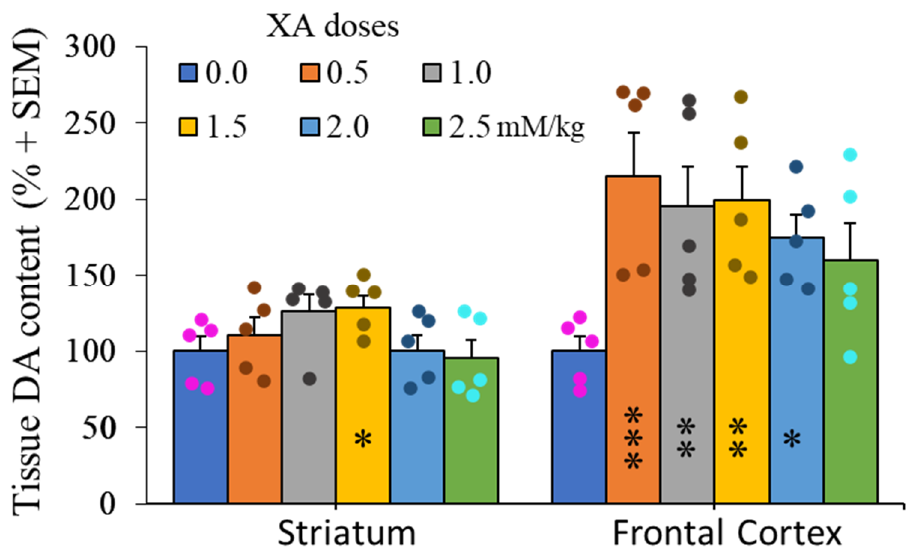
Figure 4. Dose-effect of XA administration on dopamine concentrations in the frontal cortex and striatum. Histogram of mean (+SEM) DA tissue content as a function XA doses as indicated. Rats were sacrificed 60 min after i.p injection of XA. As previously described [25], the i.p. administration of 50 mg/kg of XA to the rats induced a strong increase in the brain concentration of this compound (frontal cortex and caudate putamen in particular). The figure shows a two-fold increase of DA concentrations in the frontal cortex after 0.5 mM/kg and these concentrations remain stable at higher doses of XA. By contrast, the change of DA-tissue content in the striatum is very low and almost not significant, even at the highest concentration of XA. Filled circles represent individual data point sets for each bar of the histogram accordingly. * p < 0.05; ** p < 0.01; *** p < 0.001; post ANOVA comparison with control animals using the uncorrected Fisher’s LSD statistical test.